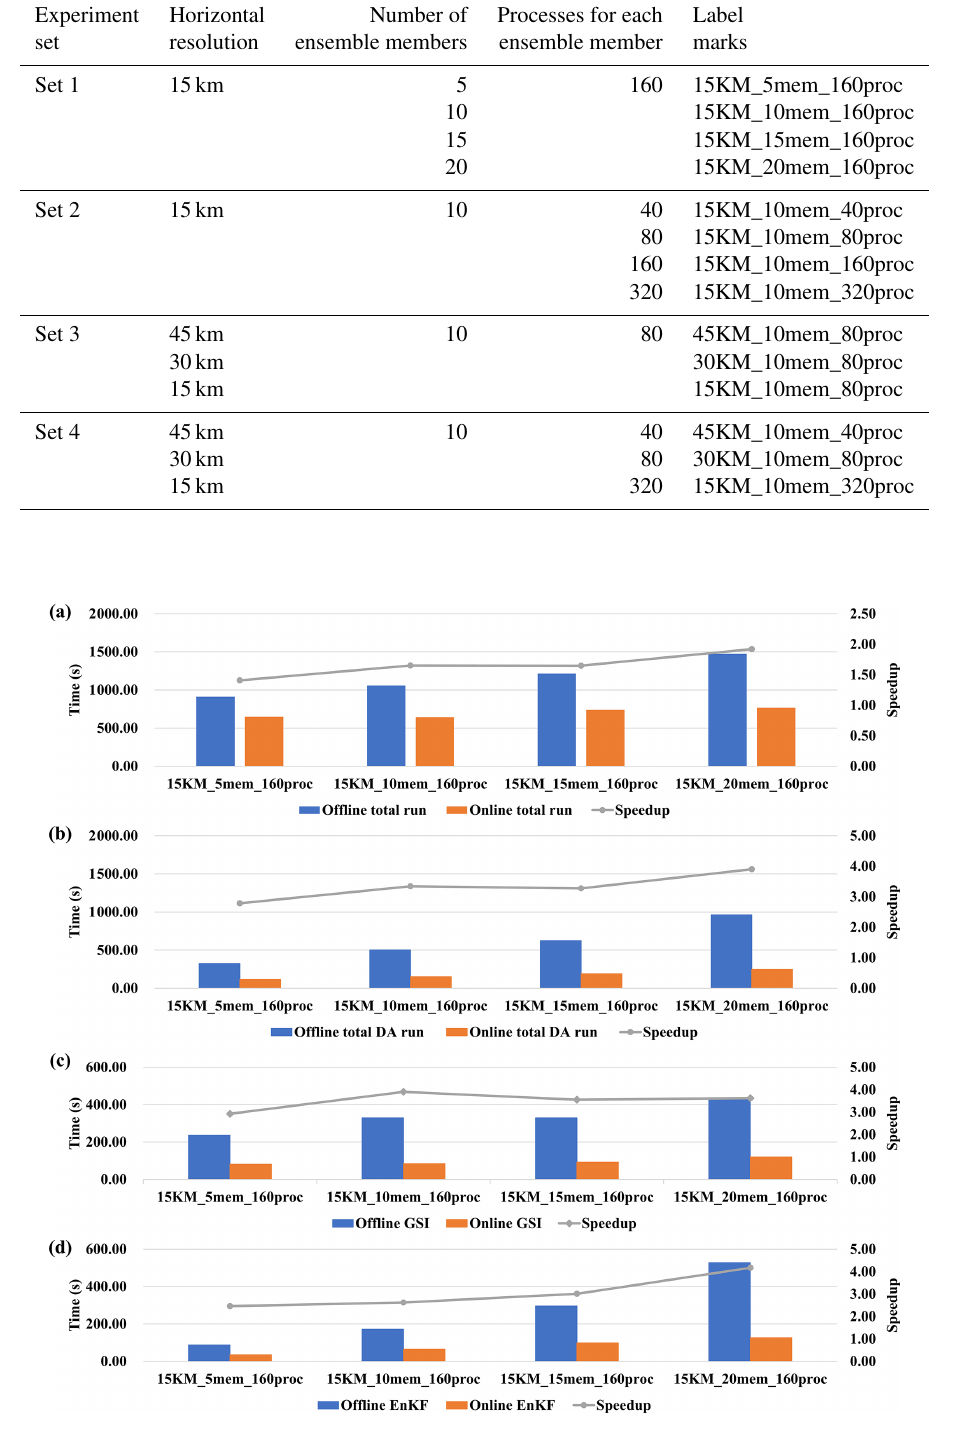
Figure 13. Execution time (colored bars) corresponding to the online and offline WRF-GSI/EnKF and the corresponding speedup (gray line, ratio of offline execution time to online execution time) from experiment set 1 in Table 2. (a) Total run (including model run and DA algorithms run). (b) DA algorithms (including GSI and EnKF) run. (c) GSI run. (d) EnKF